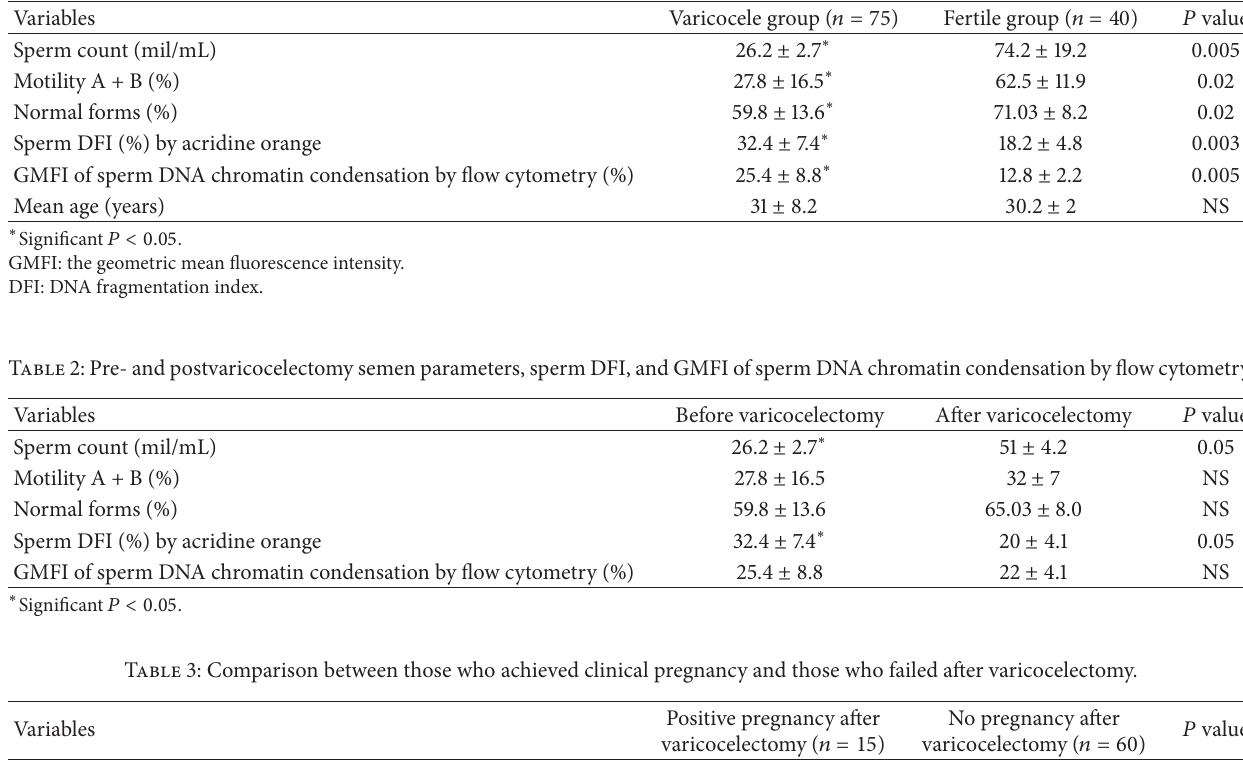
Table 1: Clinical and laboratory data of studied groups (mean ± SD).